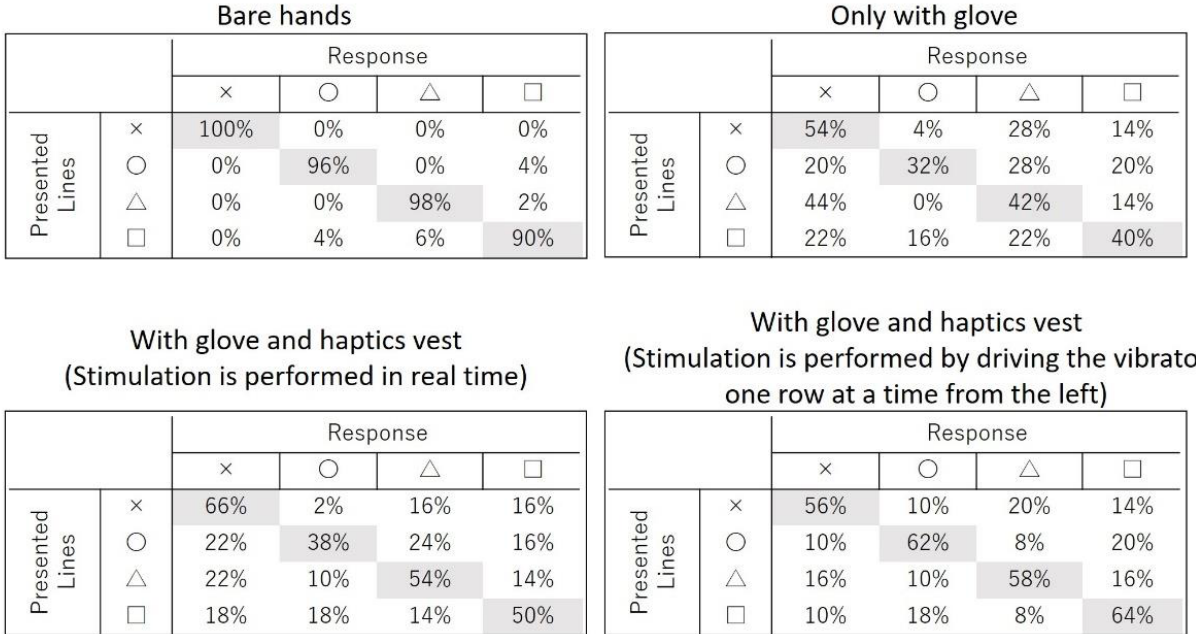
Figure 14. Results of experiment 2.